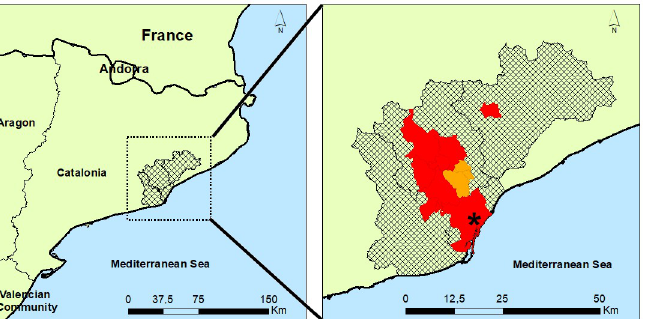
Fig 3. Catalonian districts invaded by Xylotrechus chinensis up to July 2020. The four townships invaded up to July 2018 are in orange; the eight new townships invaded up to July 2020 are in red. The black asterisk signals the city of Barcelona. Source map of Catalonia obtained from BDLJE CC-BY 4.0 Spanish ‘Instituto Geogra´fico Nacional’ http:// www.ign.es/. The districts and towns were reproduced from the Cartographic and Geological Institute of Catalonia, https://www.icgc.cat/, under a CC BY 4.0 license. The data were assembled using ArcMap 10.3.1 (May 13, 2015) https://desktop.arcgis.com/es/arcmap/10.3/main/map/what-is-arcmap-.htm.